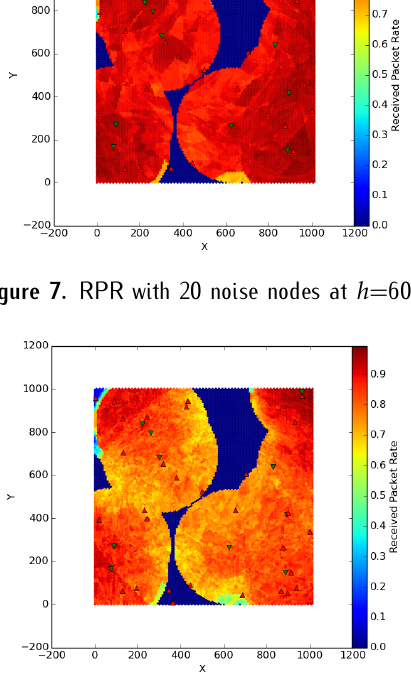
Figure 8. RPR with 30 noise nodes at h =60m